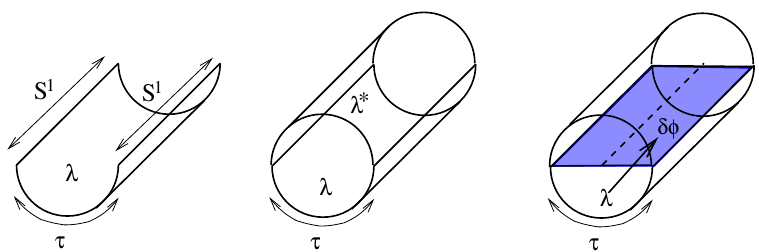
Figure 1. Left: path integral for a perturbed thermo(cid:12)eld double state of two CFTs on S 1 (ends are periodically identi(cid:12)ed). Middle: path integral used to compute t = 0 observables for this state. Right: euclidean gravity solution dual to the perturbed CFT state (interior of torus. Initial data for the Lorenzian geometry corresponding to our state is obtained via analytic continuation of the (cid:12)elds on the blue